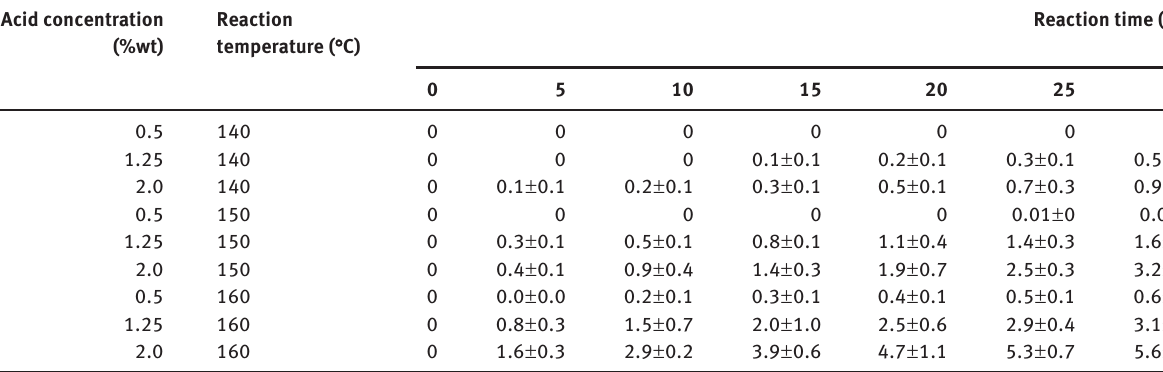
Table 4 Concentration of furfural in the liquid hydrolyzate samples, g/l. Acid